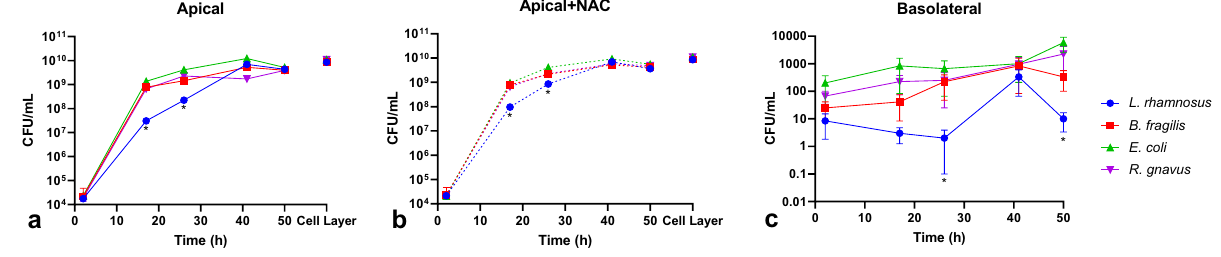
Figure 2. Bacterial growth was similar in magnitude for all groups and unaffected by antioxidant supplementation. Bacterial concentration in apical media ( a ) and NAC supplemented apical media ( b ) collected at various timepoints of the experiment and from the cell layer at the conclusion of the 50 h co-culture. ( c ) Bacterial concentration in basolateral media collected at various timepoints of the experiment. [n = 10 samples from 5 independent experiments, * = Significant difference compared to all other groups ( L. rhamnosus p = 0.04 to < 0.0001)].